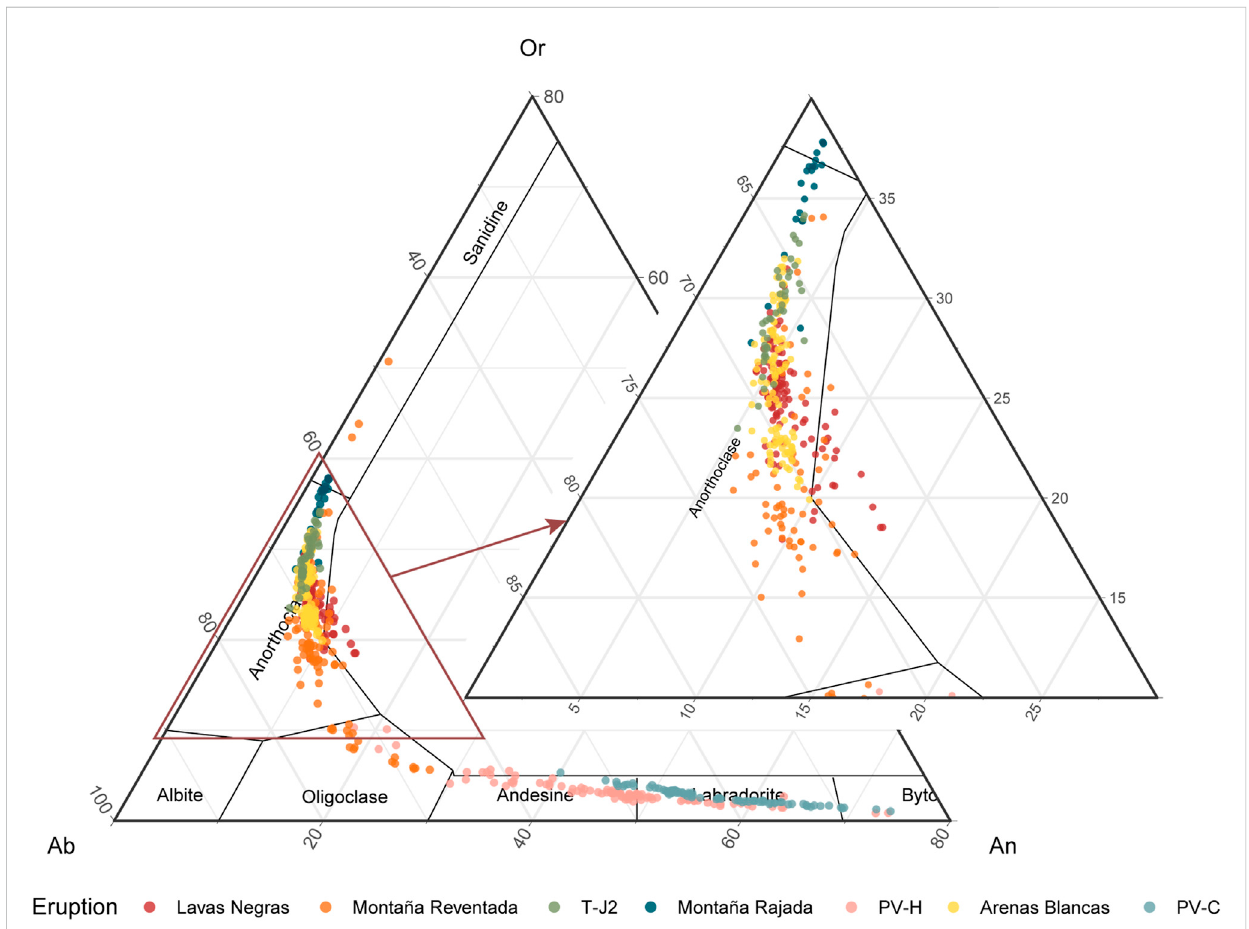
FIGURE 2 Ternaryfeldsparcompositiondiagram(Deeretal.,1992)showingAnorthite(An)-Albite(Ab)-Orthoclase(Or)compositionsofT-PVfeldsparsanalysed inthisstudybyEPMA: LavasNegras(darkred),MontañaReventada(orange),TeideJ2(T-J2)(light green),MontañaRajada(darkblue),PicoViejoH(PV-H) (pink), Arenas Blancas (yellow) and Pico Viejo C (PV-C) (light